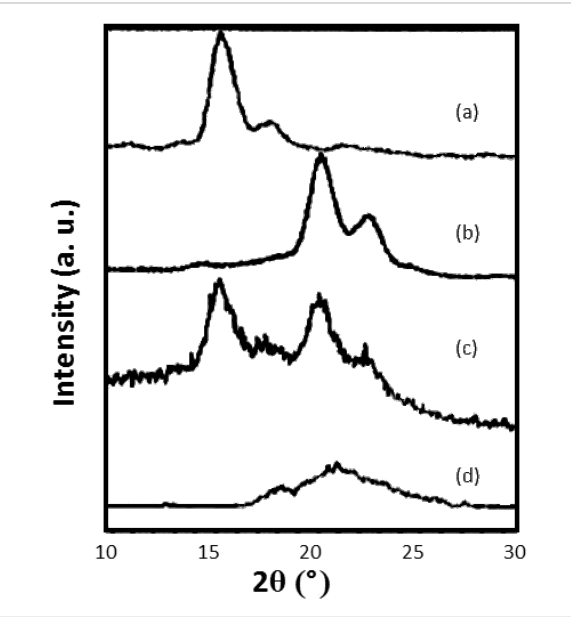
observed, as indicated by the single T g exhibited in DSC obser- vations of their ternary coalesced blend (Figure 9). Solid-state NMR observations [ 13 C observed 1 H spin-lattice relaxation times recorded in the rotating frame, T 1 ρ ( 1 H)] of the three poly- mers in their ternary blend confirmed their intimate molecular mixing on a scale less than 5 nm.